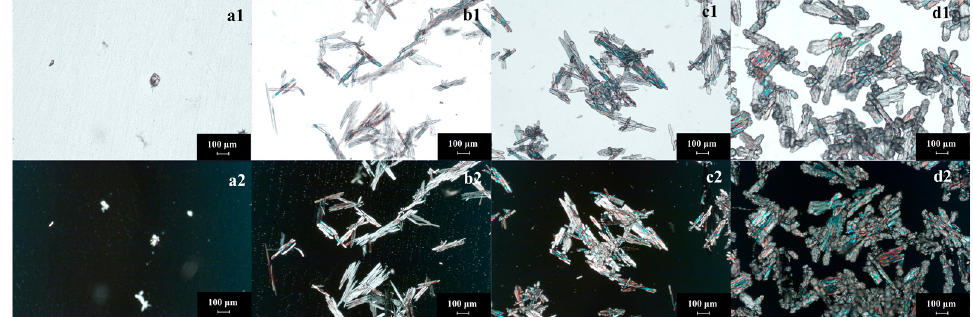
Figure 6. Image of the process of spontaneous nucleation to produce crystalline products.